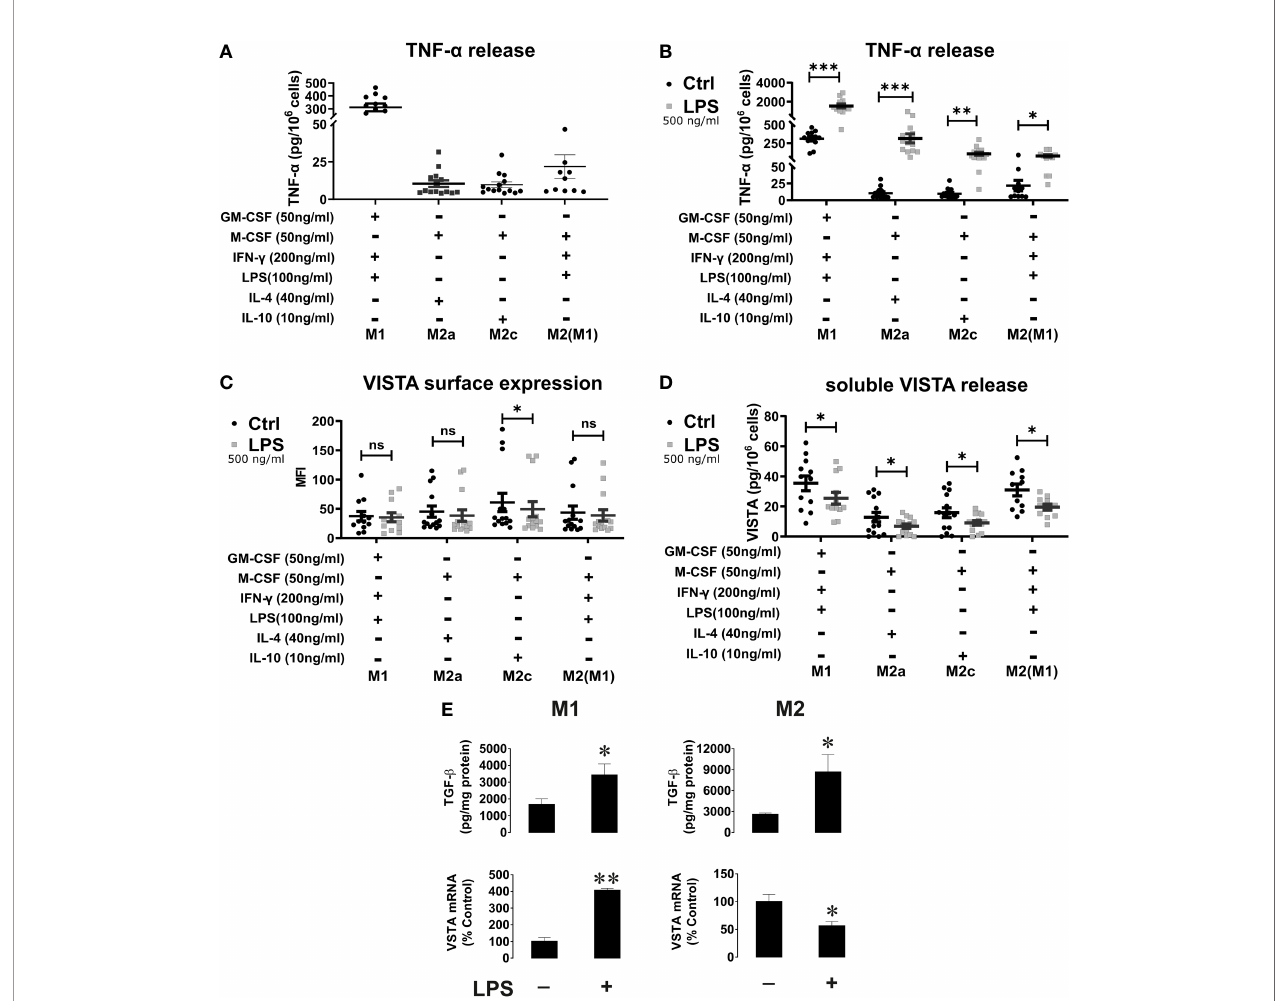
FIGURE 5 | VISTA surface expression and release of soluble VISTA after LPS stimulation in macrophages. (A) TNF- a release from activated macrophages and (B) before and after stimulation with LPS for 24h. TNF- a release after stimulation with LPS con fi rms macrophage activation. (n=12-14) (C) VISTA surface expression was determined by fl ow cytometry before (grey squares) and after stimulation with LPS (black). (D) Release of soluble VISTA was determined by a sandwich ELISA. (E) The effects of LPS on TGF- b expression and VISTA mRNA levels in M1 and M2 macrophages. M1 and M2 macrophages were exposed to 500 ng/ml LPS for 24 h. Cell-associated TGF- b (i.e. total amount of TGF- b expressed by the cells and performing autocrine action) was measured by ELISA. VISTA mRNA levels were measured by qRT-PCR as described in Materials and Methods . Data are the mean values ± SEM (n=3). *p < 0.05, **p < 0.01, ***p < 0.001, ns, non- signi fi cant